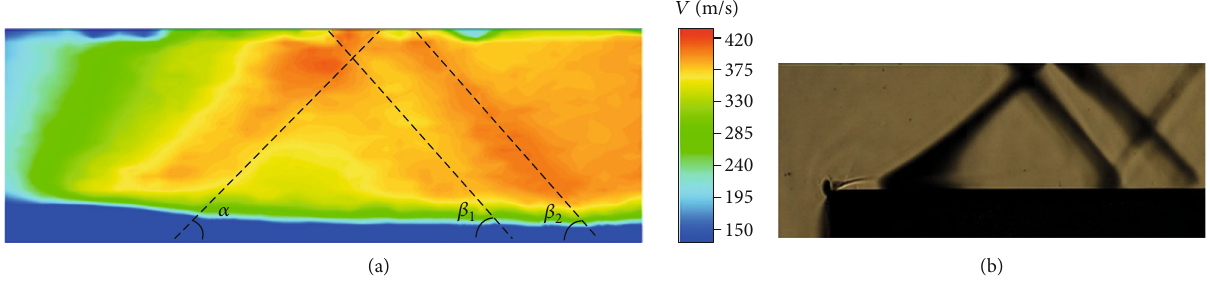
Figure 5: (a) Velocity contours and (b) Schlieren image obtained experimentally ( w = 30 mm, h = 10 mm).